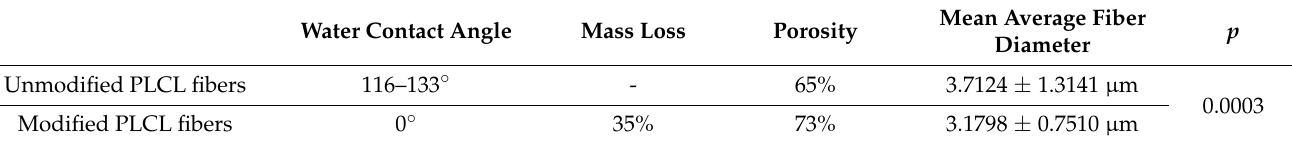
Table 3. Properties of electrospun scaffolds before and after the